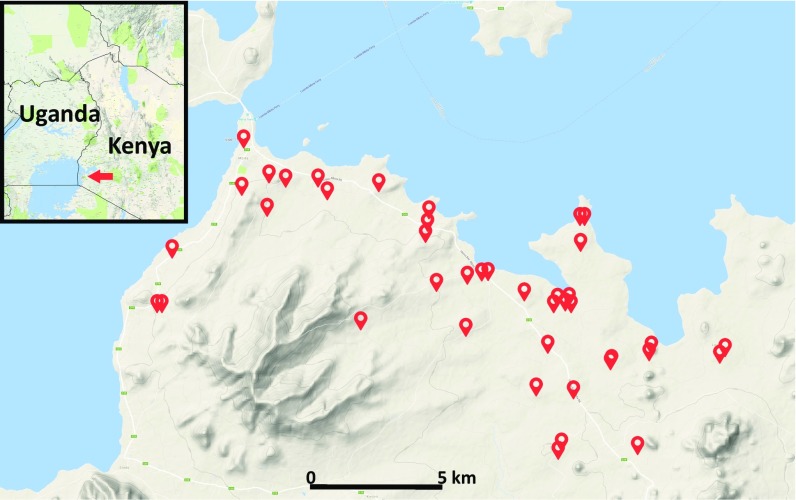
Volatile samples were collected from primary school children at 41 schools in western Kenya.